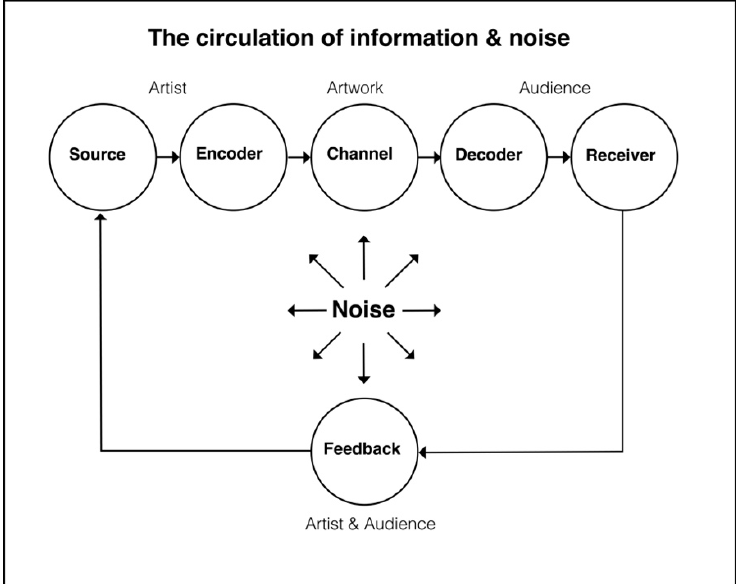
Figure 3. Flow of information from the artist who encodes the known and unknown information in the channel or artwork. This is decoded by the audience, and this may include decoding via curators and historians, who will, in turn, respond to the receipt of new information and this will be fed back to the artist. This diagram is an adaptation of Shannon and Weaver’s model of communication (Shannon and Weaver [1949] 1998) which suggests noise disrupts communication as it is channelled and this revison suggests that noise or unknown information is present at each stage of the communication